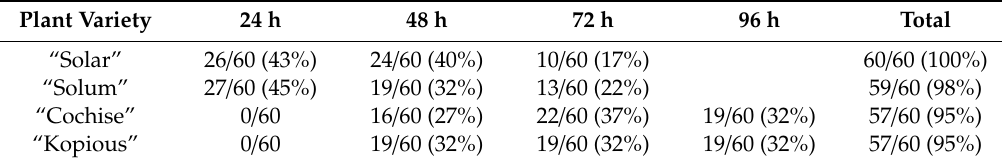
Table 5. More rapid seed germination in drought tolerant “Solar” than conventional Kopious.”